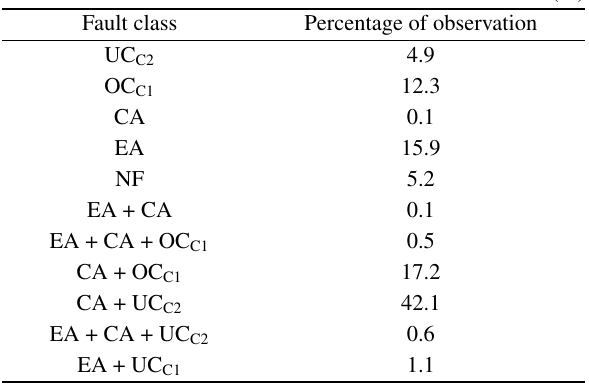
Table 6 Fault labels and observation percentages of Dataset